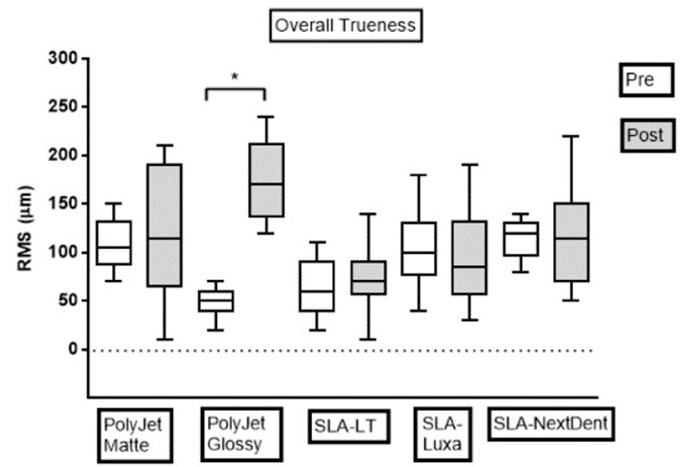
Figure 5. Boxplot demonstrating dimensional accuracy measurements (pre- and post-sterilization) reflecting overall trueness RMS values in all groups. Pre, pre-sterilization; Post, post-sterilization; RMS, root mean square. The dotted line represents the CAD reference line.